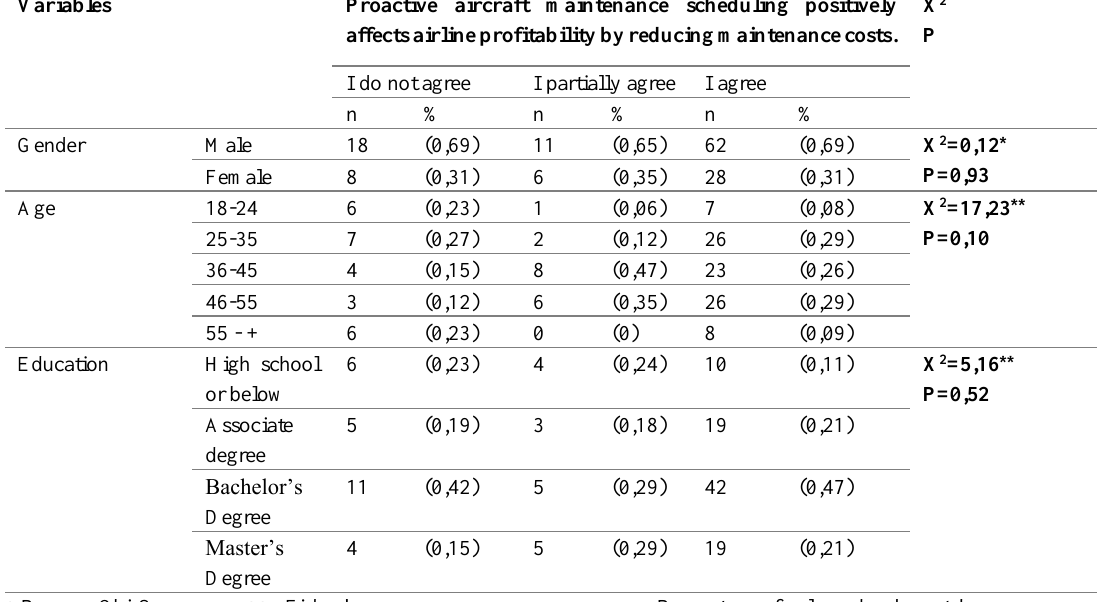
* Pearson Chi-Square ** Fisher's Percentage of column has been